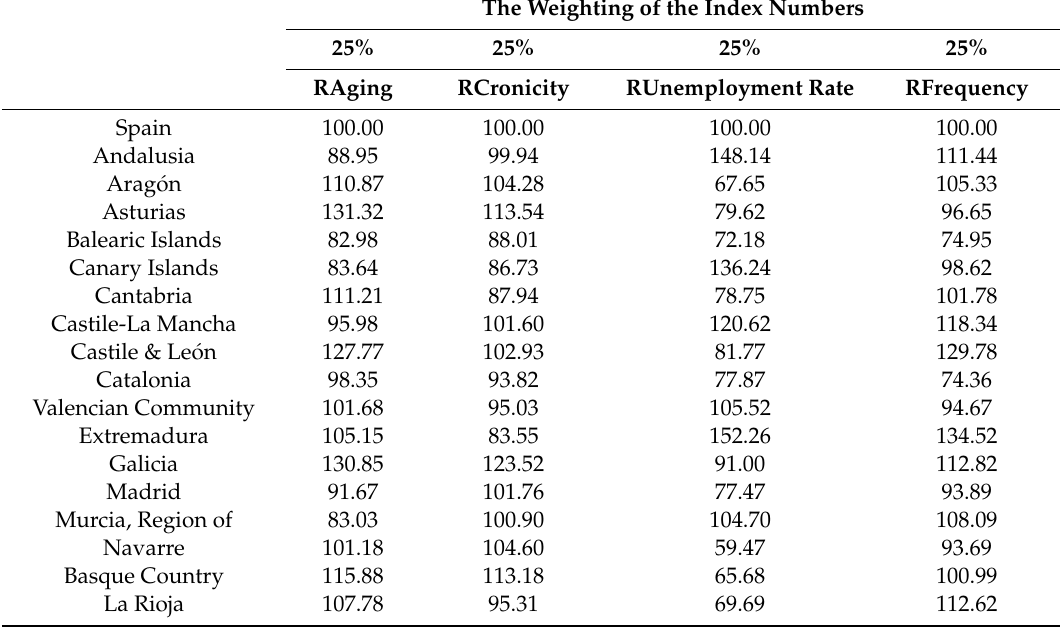
Table 2. The weighting of the index numbers of aging, chronicity, unemployment rate, and level of income and frequency in general medicine and